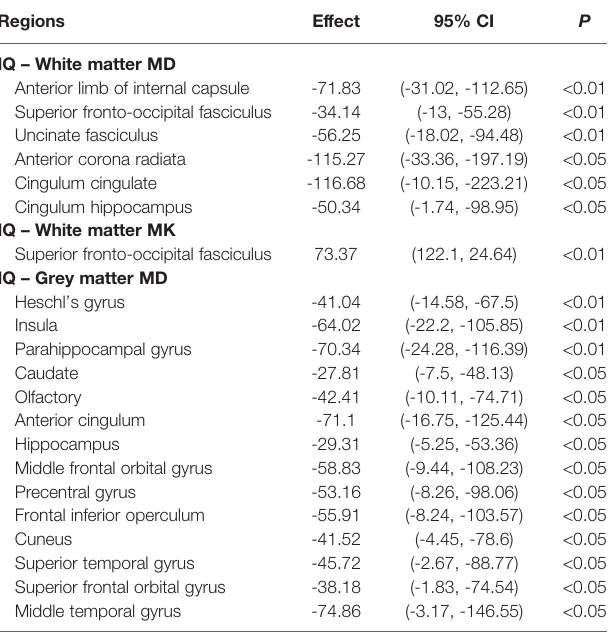
TABLE 3A | Multiple regression analysis of the relationships between IQ and diffusion metrics of all brain regions in the AAL atlas. Regions